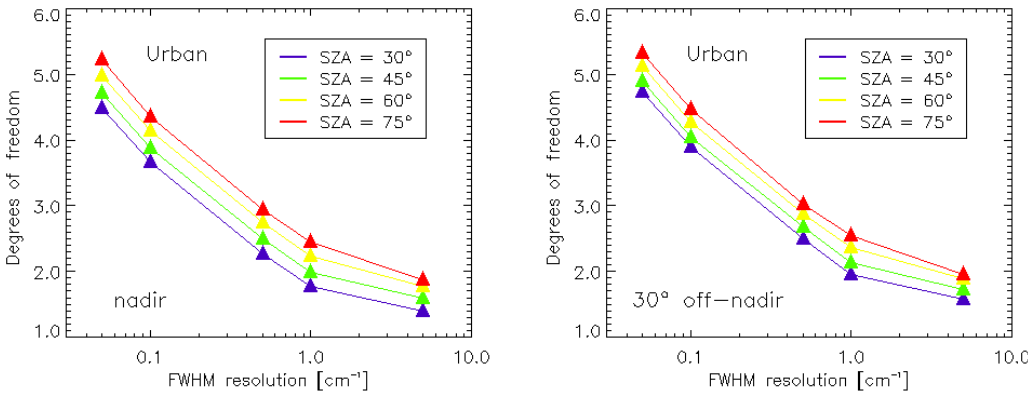
Figure 4. Nadir and 30 ◦ off-nadir urban scenario total degrees of freedom for different instrument resolution and four different solar zenith angle (30, 45, 60, 75 ◦